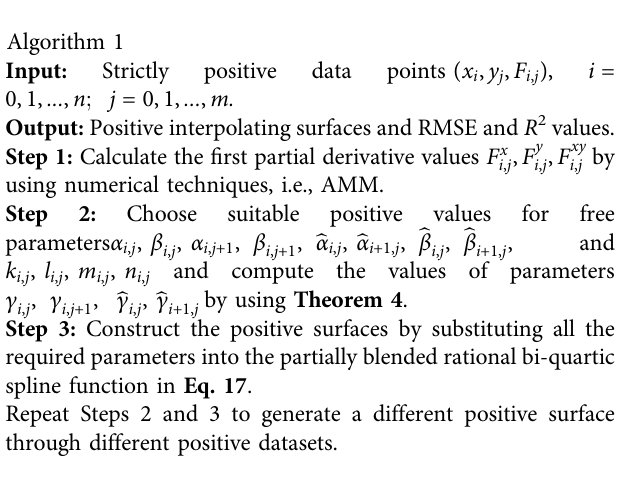
Frontiers in Physics |